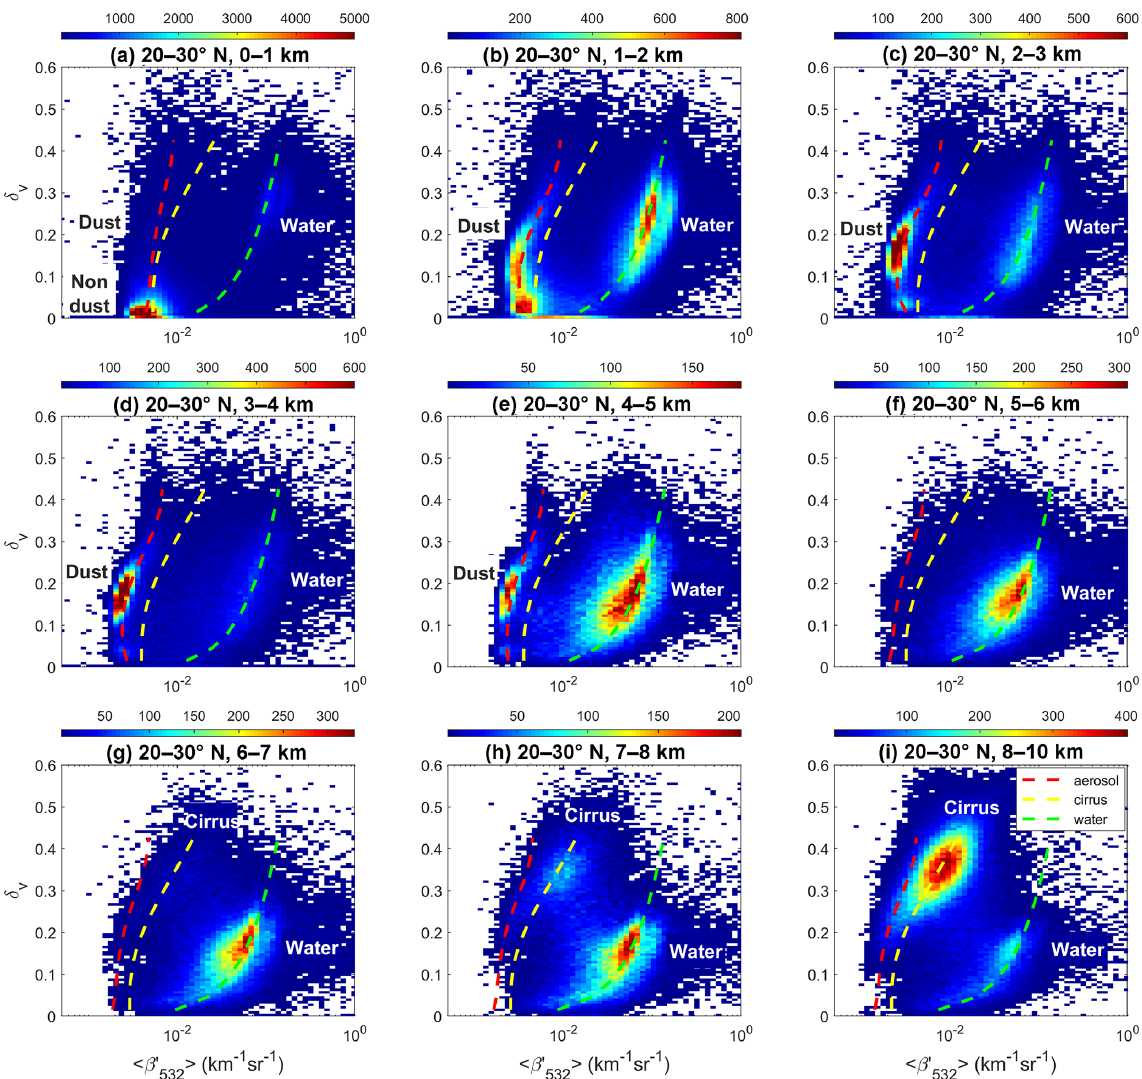
(cid:105) Figure 3. CALIOP measurements (colored 2-D distributions) and the (cid:104) β (cid:48) 0 parameters used in constructing PDFs for aerosols (red dashed 532 line), ice clouds (yellow dashed line), and water clouds (green dashed line), showing the evolution of clusters with increasing altitude in the 20 to 30 ◦ N latitude band. The labels “non-dust”, “dust”, “ice”, and “water” indicate, respectively, where non-dust aerosol or a mixture of non-dust aerosol with a small amount of dust aerosol, dust aerosol, ice cloud, and water clouds is clearly identifiable. In general, the water cloud cluster is largely separated from the aerosol clusters and is hence most easily discriminated from aerosols. Relatively significant amounts of dust can be seen up to 5km and some dust can still be identified above 5km in the 5–6km altitude range in this latitude band. Ice clouds normally form at high altitudes and a significant amount of ice cloud is already seen in the 6–7km altitude range. They can form at even lower altitudes, down to ∼ 4km for this latitude band (Campbell et al., 2015). The most difficult scenario to discriminate in this latitude band is the dust that is relatively dense and at altitudes above ∼ 6km where the ice cloud can occur frequently. There is an overlap between relatively dense dust and ice cloud at 5–7km altitudes, although both of them occur very infrequently. Moving north toward the Arctic, this overlap region moves to lower altitudes (not shown) because ice clouds tend to form at lower altitudes, whereas the occurrence frequency of relatively dense dust decreases quickly when moving